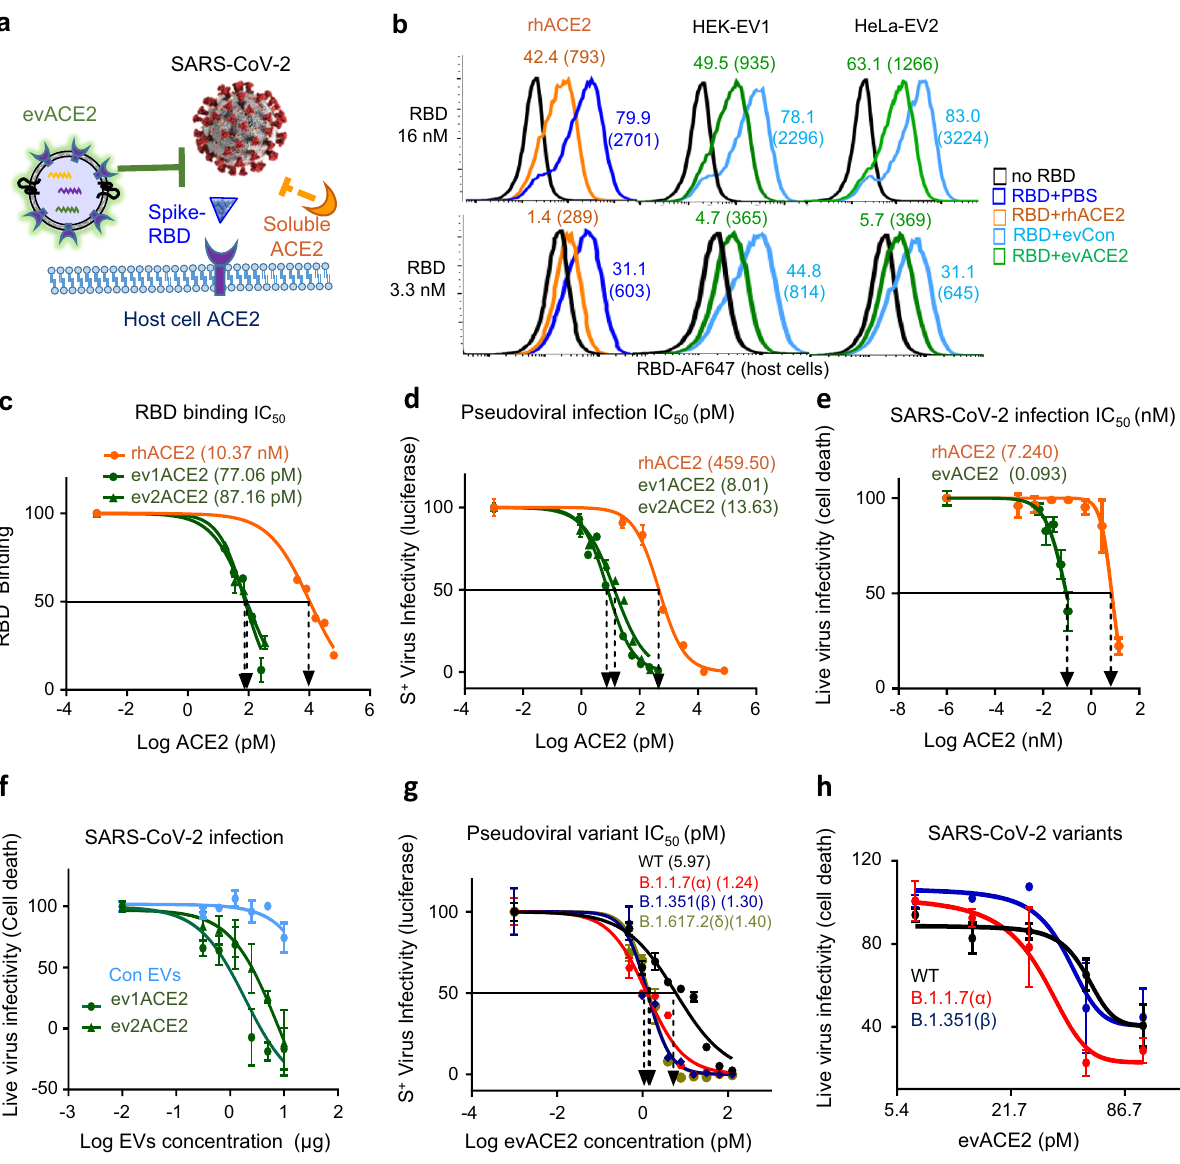
Fig. 2 Neutralization effects of evACE2 on RBD-binding and SARS-CoV-2 variant infections. a Schematic depiction of the cell-based neutralization assay. b Representative fl ow pro fi les showing the percentage ( fl uorescence mean intensity) of RBD-AF647 binding (at 16 and 3.3 nmol/L) to ACE2 + HEK-293 cells, inhibited by rhACE2 and ACE2 + EVs (evACE2) isolated from HEK-293 and HeLa cells (HEK-EV1 and HeLa-EV2, respectively) whereas ACE2 − EVs (evCon) had no neutralization effects (no RBD in black, PBS in dark blue, rhACE2 in orange, evCon in light blue, and evACE2 in green). c IC 50 of rhACE2 (orange line) and ACE2 in the EVs from ACE2 + HEK (ev1ACE2) and HeLa (ev2ACE2) cells (green lines) on 16 nM RBD-host cell binding (%). GraphPad Prism 9.0.2 was used to calculate the IC 50 . N = 2 experiments with two technical replicates for each. Data are presented as mean values ± SD. d IC 50 of evACE2, ev1 from HEK and ev2 from HeLa cells (green lines), and rhACE2 (orange line) neutralizing infections by wild-type (WT) S + pseudotyped SARS-CoV-2. GraphPad Prism 9.0.2 was used to calculate the IC 50 . N = 2 experiments with two technical replicates for each. Data are presented as mean values ± SD. e IC 50 (nM) of ACE2 in ev1ACE2 (HEK) (green line) and rhACE2 (orange line) upon wild-type SARS-CoV-2 infection. GraphPad Prism 9.0.2 was used to calculate the IC 50 with three biological replicates. Data are presented as mean values± SD. f Distinct effects of ACE2 + EVs (green lines) and ACE2 − control EVs (light blue line) on inhibiting Vero-6 cell death caused by SARS-CoV-2. N = 2 experiments with three biological replicates each. Data are presented as mean values± SD. g The IC 50 of ev1ACE2 (HEK) neutralizing infections by pseudotyped SARS-CoV-2 expressing WT (black), B.1.1.7 ( α ) variant (red), B1.351 ( β ) variant (dark blue) and B.1.617.2 ( δ ) (light green) S protein. GraphPad Prism 9.0.2 was used to calculate the IC 50 . N = 2 experiments with two technical replicates each. Data are presented as mean values± SD. h Effects of ev1ACE2 (HEK) on protecting Vero-6 cell viability against infections of SARS-CoV-2 WT (black), B.1.1.7 ( α ) variant (red) and B1.351 ( β ) variant (dark blue) ( n = 3 biological replicates). Data are presented as mean values ±